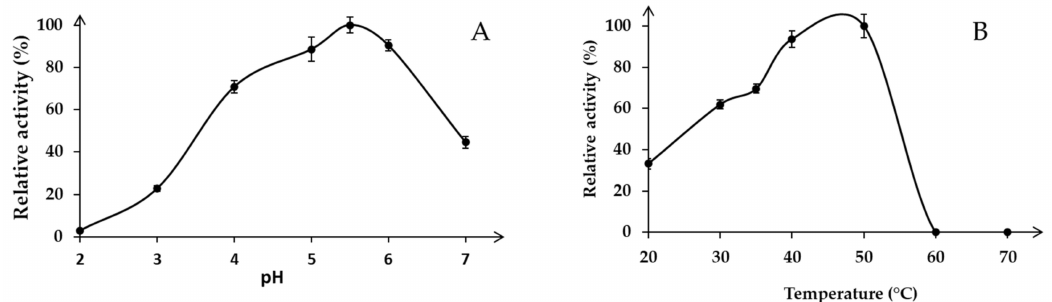
Figure 3. Effect of pH and temperature on enzyme activity: ( A ) Optimal pH in 50 mM sodium tartrate buffer from pH 2 to 4 and citrate-phosphate buffer from pH 5 to 7 at 30 ◦ C; ( B ) Optimal temperature for beechwood xylan hydrolysis (0.5%, w / v ) in the range 20–70 ◦ C at pH 5.5. Activity values were calculated as a percentage of maximum activity (set to 100%) at optimum temperature and pH. Each data point (mean +/ − standard deviation) is the result of triplicate experiments.